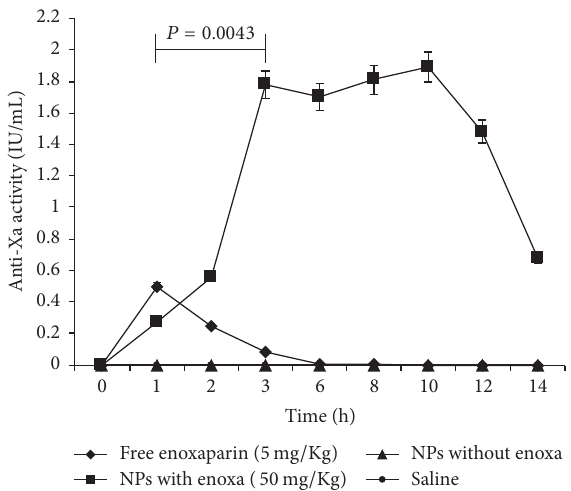
Figure 3: Anti-Xa activity in relation to time after subcutaneous application of free enoxaparin, encapsulated enoxaparin, empty nanoparticles,andsalineinthegroups. 𝑁 = 16 animals,4pergroup. 𝑃 value calculated through Mann–Whitney test. NPs: nanoparticles.